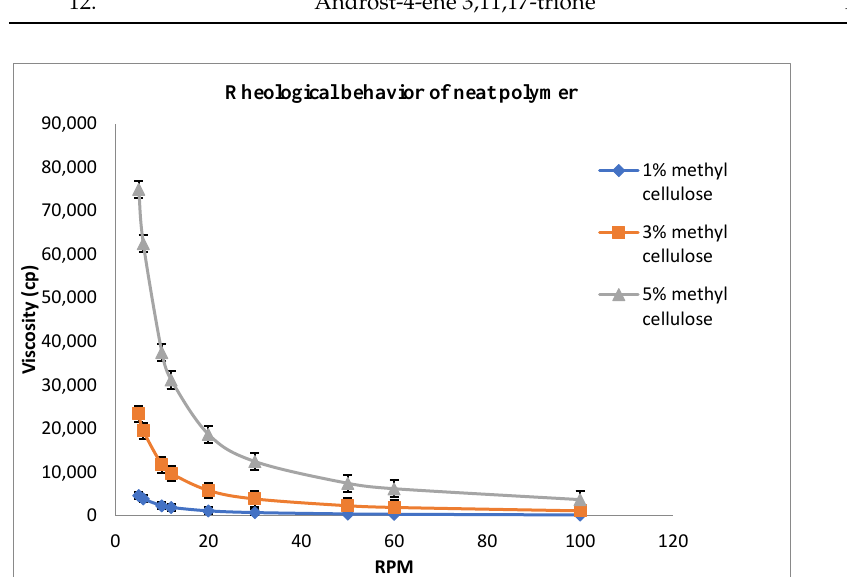
Figure 1. Rheological behavior of the neat polymer solutions (n = 3).